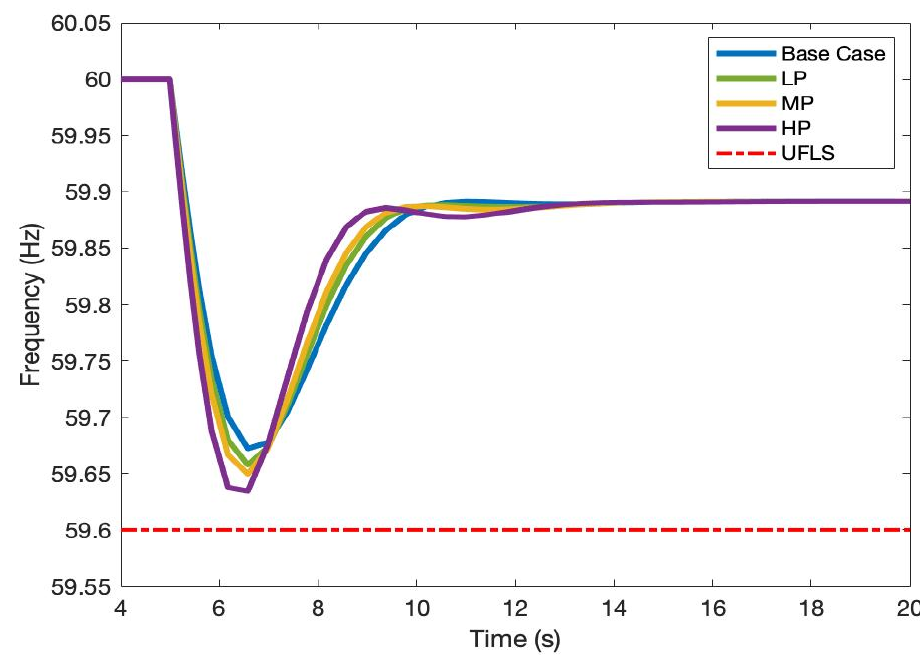
Figure 8. Frequency response under peak load conditions in 2023. Table 6. Online generation under base load conditions in